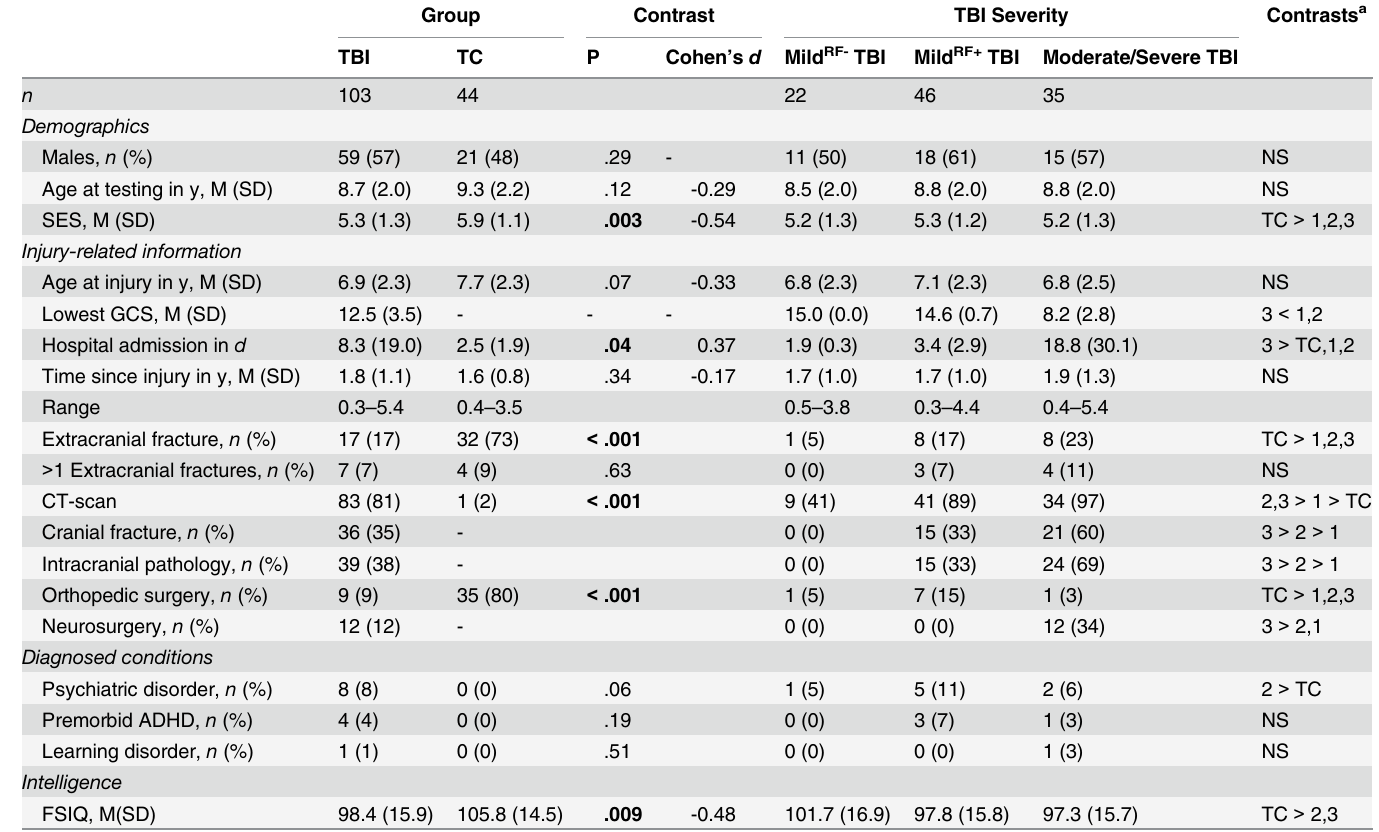
Table 1. Demographics, injury-related variables, clinical diagnoses and intelligence in the TBI, TC and TBI severity groups. Group Contrast TBI Severity Contrasts